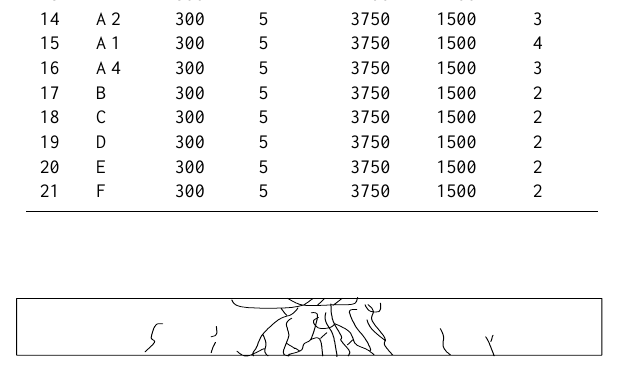
Fig. 6. Crack pattern for test No. 14 (type A2, beam m =300kg, V col =5m/s). Figure 6. Crack pattern for test No. 14 (type A2, beam m = 300 kg, V